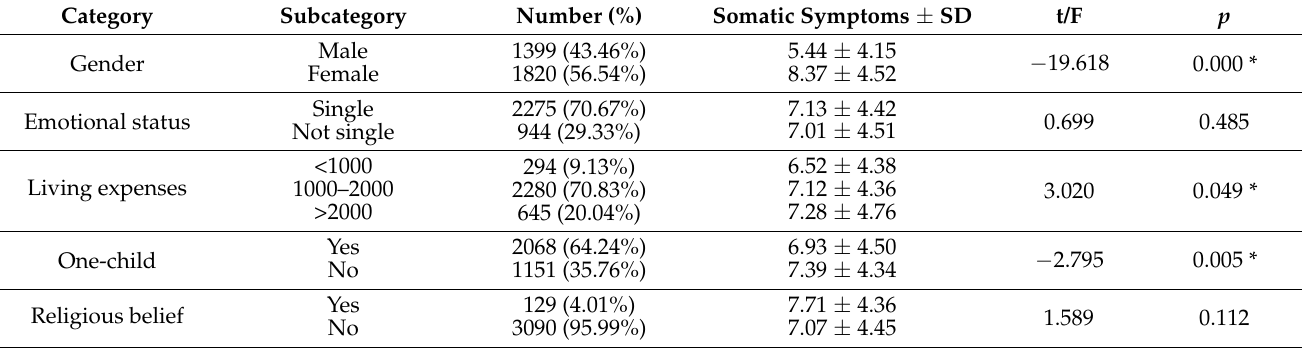
Table 3. Descriptive statistics and the distribution of somatic